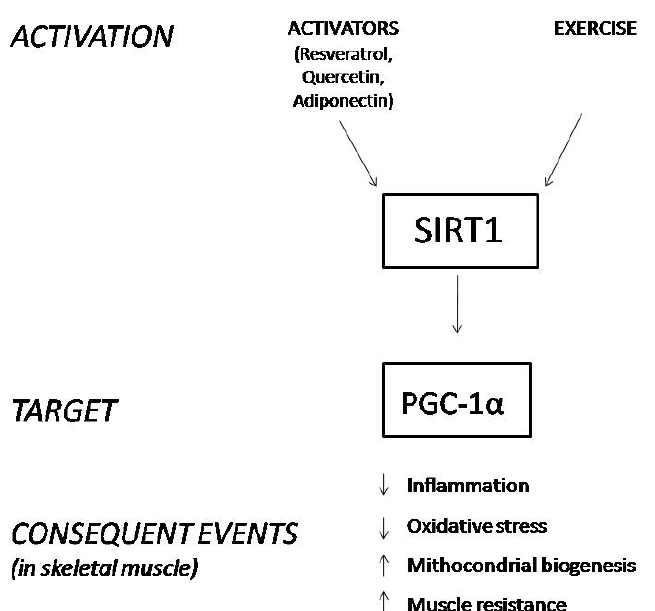
Figure 1. Schematic representation of the consequences derived from SIRT1 stimulation in skeletal muscle.